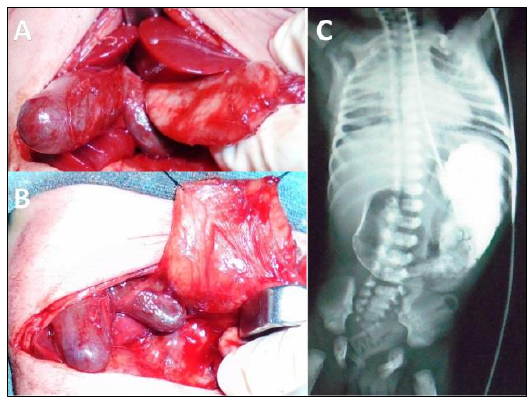
Figure 1: Intra-operative picture showing duplication of gallbladder with duodenal atresia (A); duodenotomy with stay sutures in place along with duplication of gallbladder (B); upper gastrointestinal contrast study showing complete duodenal obstruction with absence of air distally